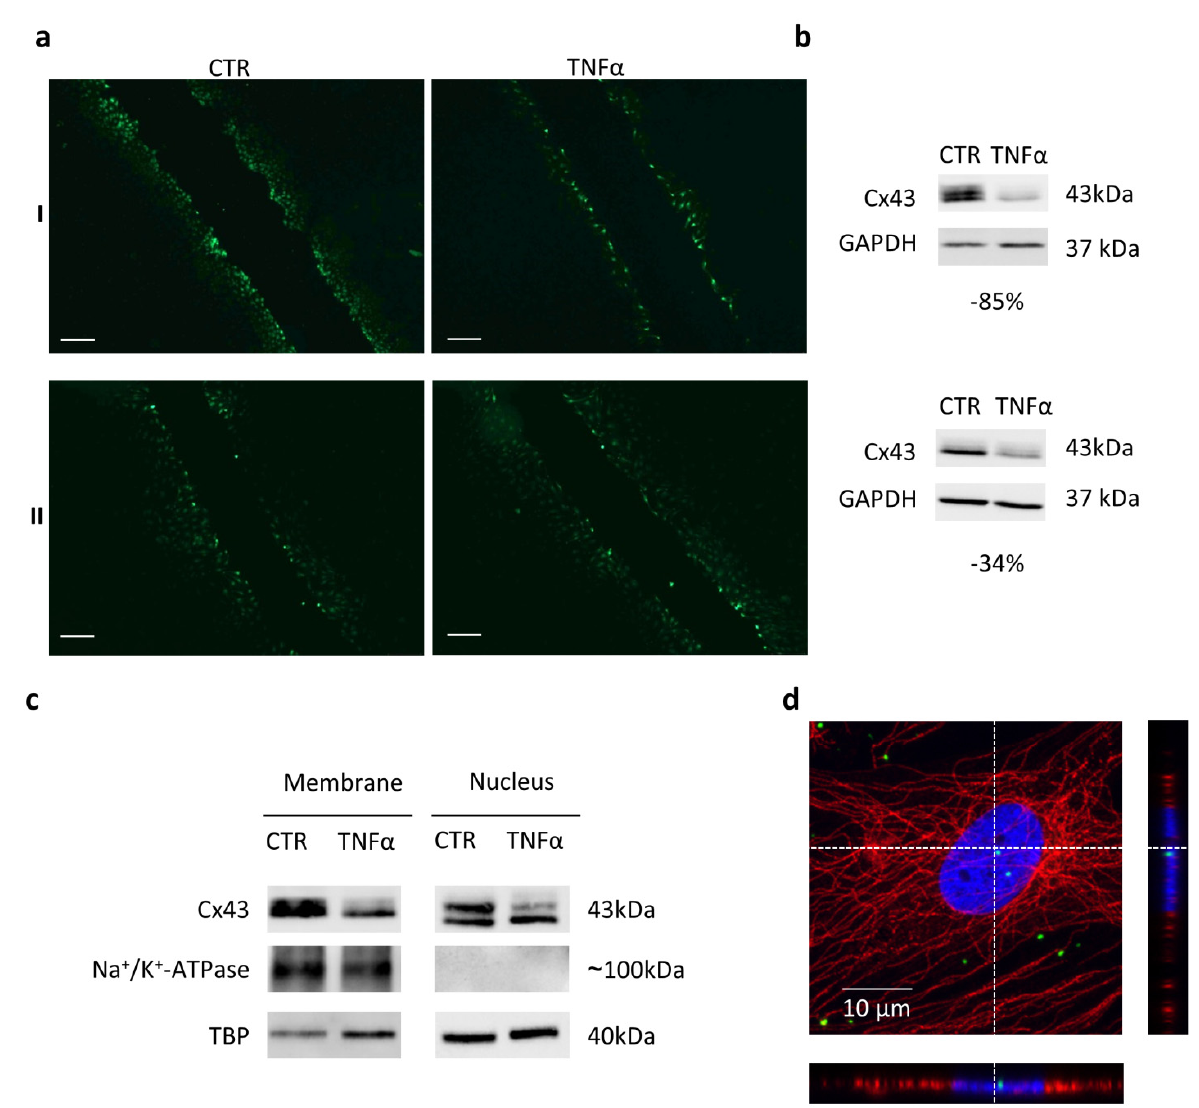
Figure 5. ( a ) Illustrative images of scrape loading/dye transfer (SL/DT) assay in CTR ( on the left ) and TNF α -treated ( on the right ) CH, at day 3. Scale bars: 200 µ m. ( b ) Immunoblot of each experiment is reported. The percentage of decrease in Cx43 in TNF α -treated CH compared to CTR is shown. ( c ) Western blot analysis of Cx43 expression and modulation in membrane and soluble nuclear fractions of CTR and TNF α -treated CH at day 3. Na + /K + -ATPase and TBP are shown as control for the membrane and nucleus fraction, respectively. ( d ) Laser scanning confocal microscopy of CH treated with TNF α for 3 days. Cx43 and β -Tubulin were revealed with an Alexa Fluor ® 488 (Cx43) and 568 ( β -tubulin) conjugated antibody (green and red respectively), nuclei were stained with DAPI (blue) (magnification 63 × ). The scale bar indicates 10 µ m, and the orthogonal views were obtained by Fiji software (ImageJ 1.51). CTR: control (untreated), Cx43: Connexin 43, GAPDH, Glyceraldehyde-3-Phosphate Dehydrogenase, Na + /Ka + ATP-ase: sodium–potassium ATPase, TBP: TATA-bindin protein, TNF α : tumor necrosis factor